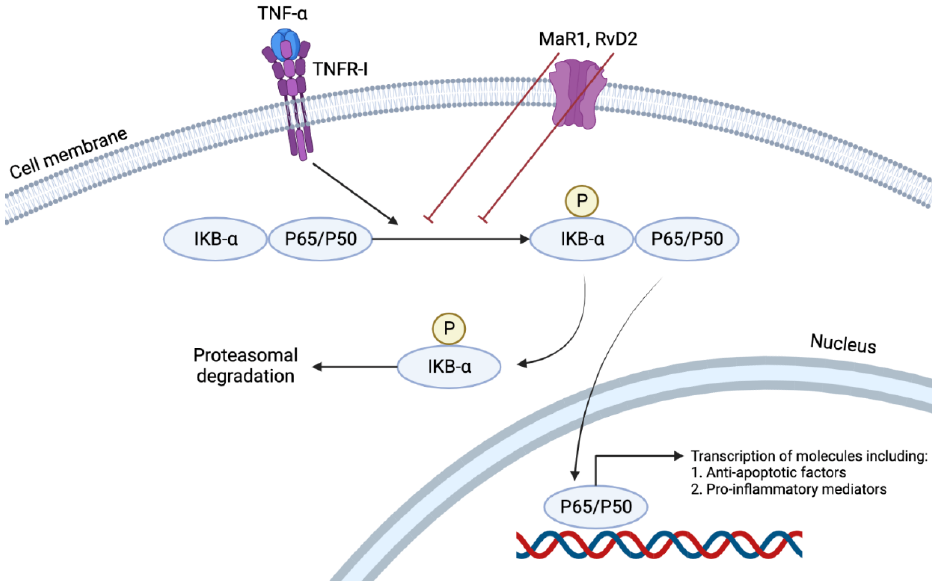
Figure 4. TNF α induces the NF κ B pathway by nuclear translocation of p65. This pathway results in the transcription of many pro-inflammatory cytokines such as TNF α , Interleukin (IL)-1, IL-6, and IL-8. RvD2 or MaR1 treatment reduces p65 nuclear translocation, demonstrating their anti-inflammatory and pro-resolving characteristics in their local environment.